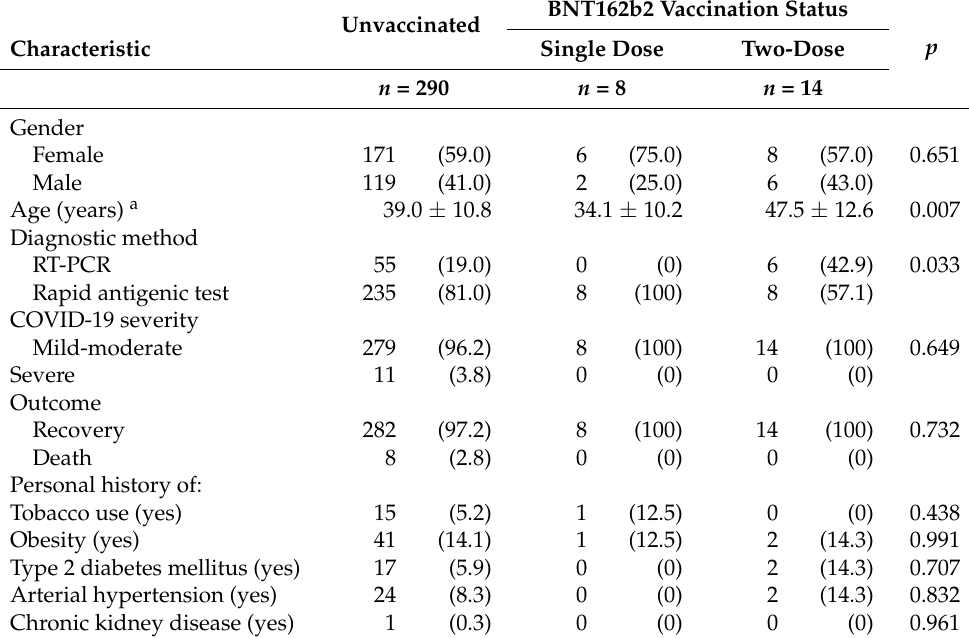
Table 1. Characteristics of the study sample for selected variables, Mexico